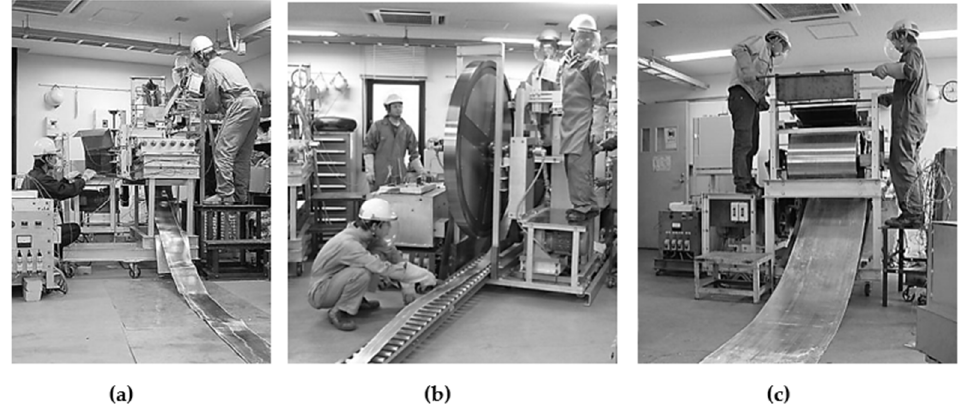
Figure 4. Photographs of casting being conducted. ( a ) Roll diameter is 300 mm and width is 200 mm. Roll speed is 90 m/min. ( b ) Roll diameter is 1500 mm and width is 100 mm. Roll speed is 60 m/min. ( c ) Roll diameter is 600 mm and width is 600 mm. Roll speed is 30 m/min.